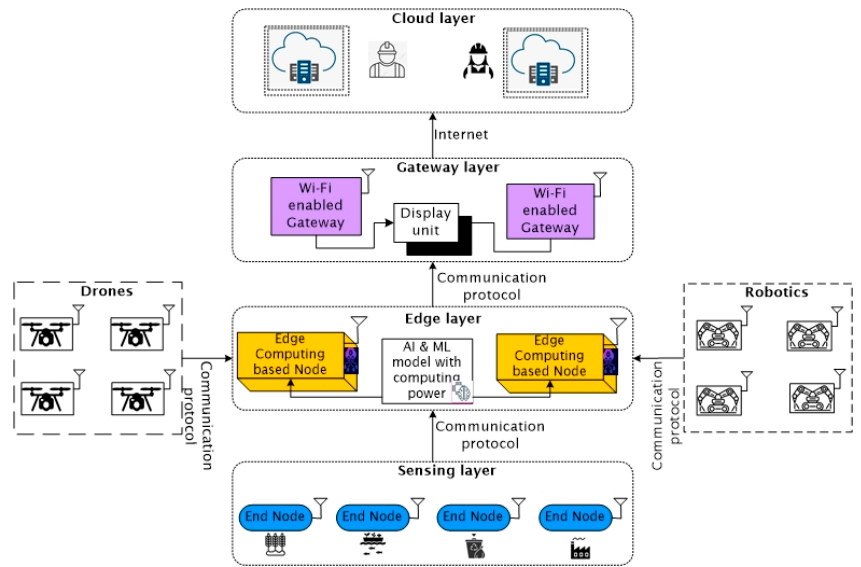
Figure 3. Hybrid framework with the integration of multiple emerging technologies.